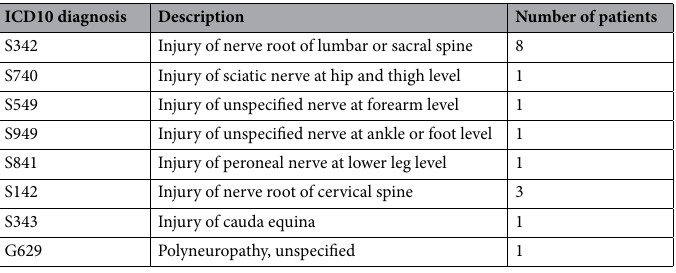
Table 1. Overview of main cause of pain based on ICD10 classification system (n =